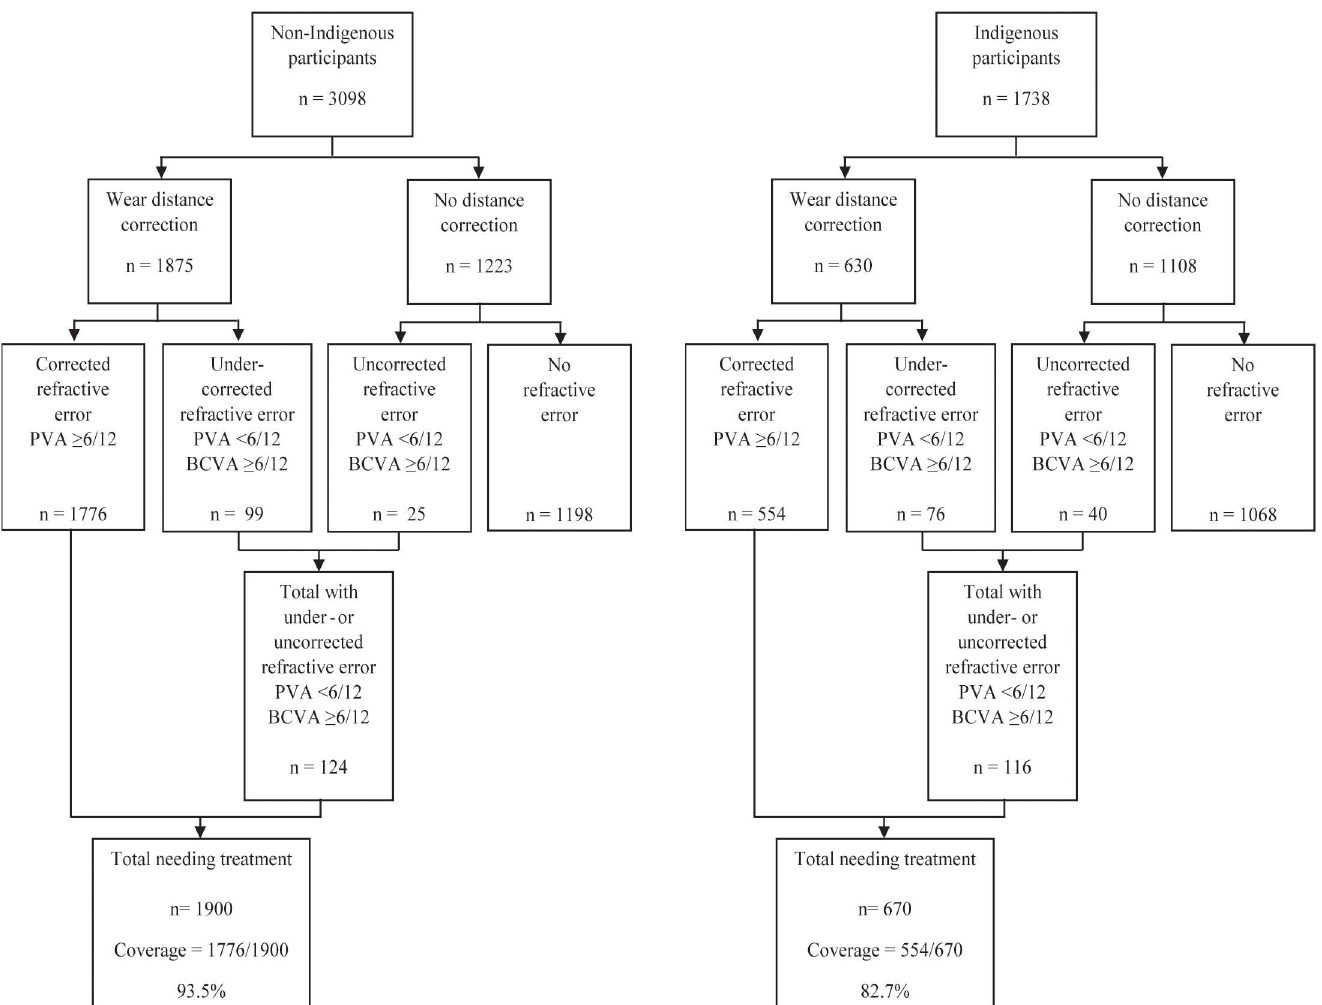
Fig 1. Flowcharts for treatment coveragerates for refractiveerror in the National Eye Health Survey. PVA = presentingvisual acuity; BCVA = best- corrected visual acuity.